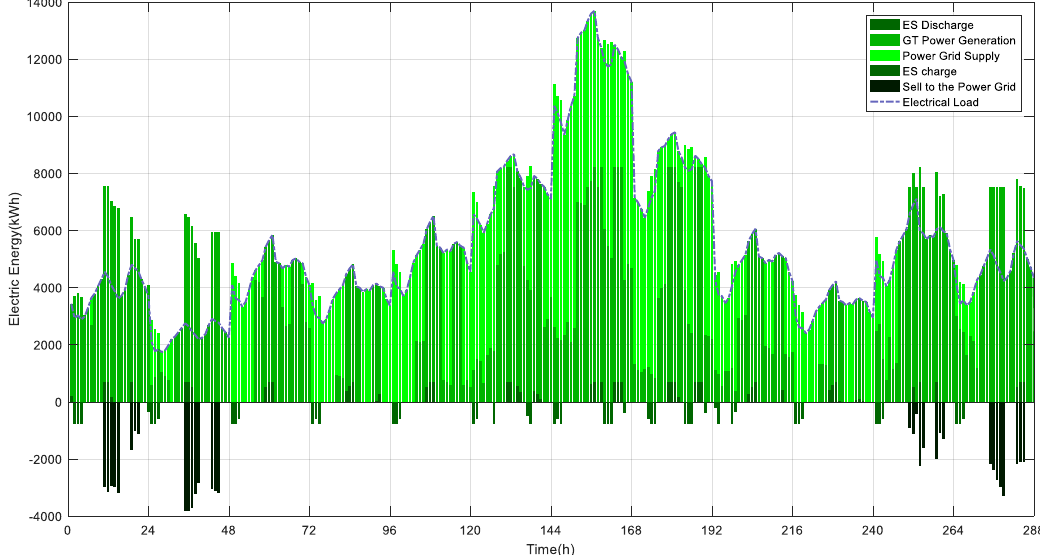
Figure 12. Output situation of daily running power-conservation device.